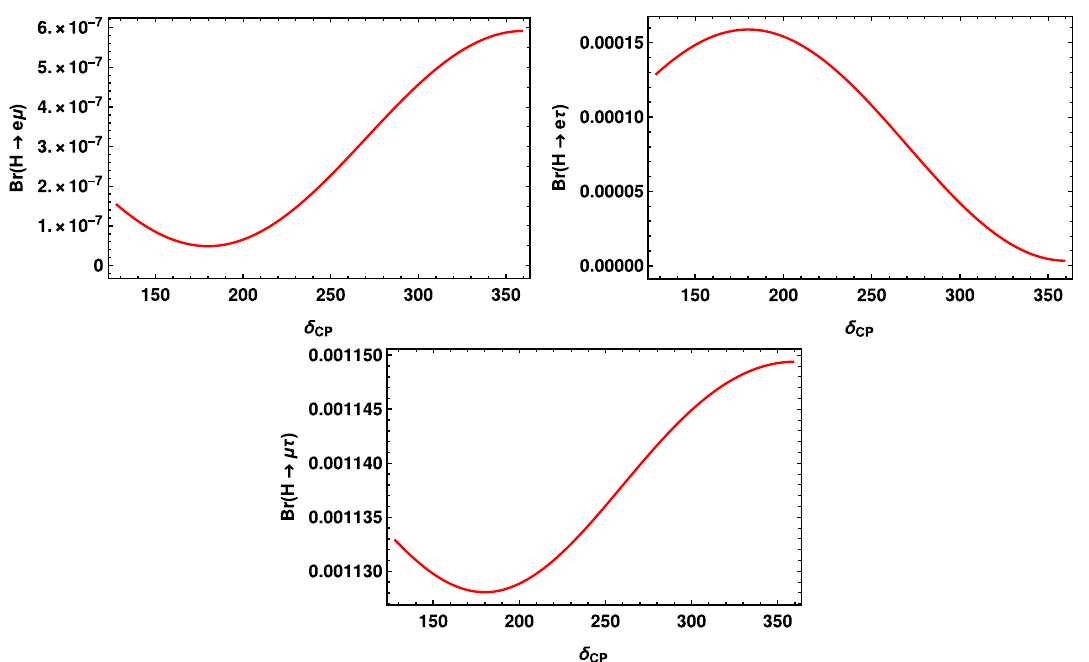
Fig. 6 Plots between Br ( H → (cid:2) α (cid:2) β ) and δ CP for the case of NO, without applying the constraints from Br ((cid:2) α → (cid:2) β γ) . See the caption of Fig. 3, for parametric values and neutrino oscillation observables, which are used in these